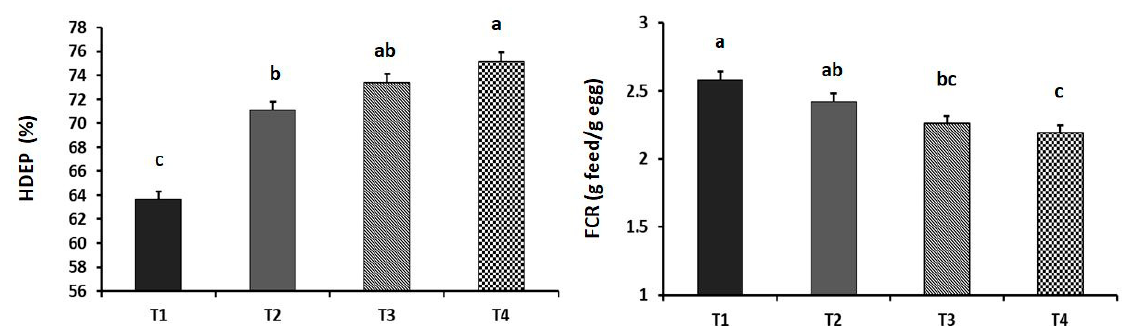
Figure 1. Effect of the dietary supplementation of guanidinoacetic acid (GA) on hen-day egg production (HDEP) ( p = 0.016 and 0.873 as linear and quadratic, respectively) and feed conversion ratio ( p = 0.018 and 0.452 as linear and quadratic, respectively) of commercial laying hens at the late stage of production. T 1 = control group; T 2 = group supplemented with 0.5 g GA kg − 1 diet; T 3 = group supplemented with 1 g GA kg − 1 diet; T 4 = group supplemented with 1.5 g GA kg − 1 diet. Means with different letters (a, b, and c) significantly differ at p ˂ 0.05.